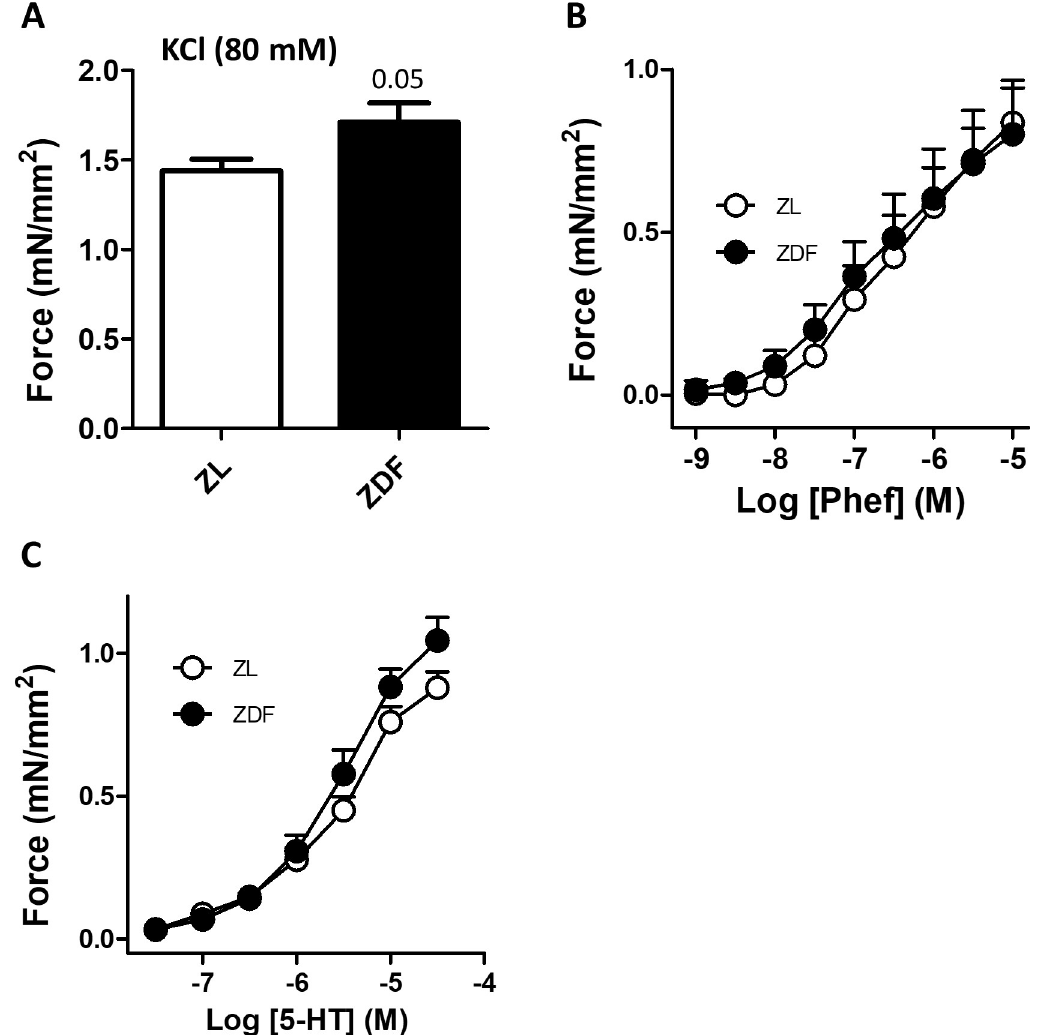
Fig 4. ZDF rats show normal PA pulmonary artery contraction. (A) Contractile responses to 80 mM KCl. (B and C) Cumulative concentration-response curves to (B) the alpha-adrenergic agonist phenylephrine and (C) serotonin (5-HT). Results are expressed as means ± SEM of 5 (ZDF) and 4 (ZL) rats in duplicate. P = 0.05, ZDF versus ZL (unpaired t